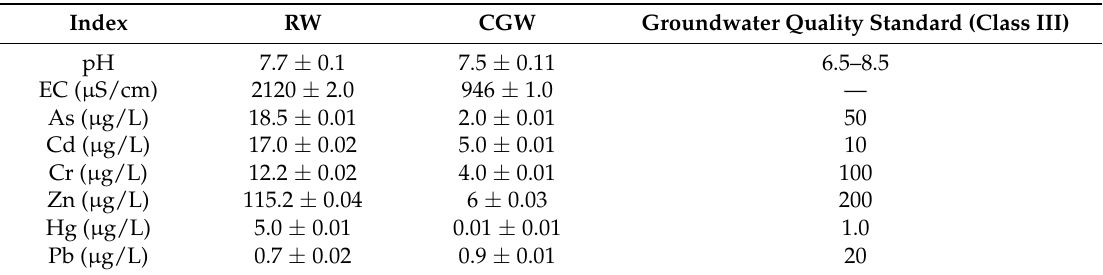
Table 3. Physical and chemical characteristics of the irrigation waters used in the plots.